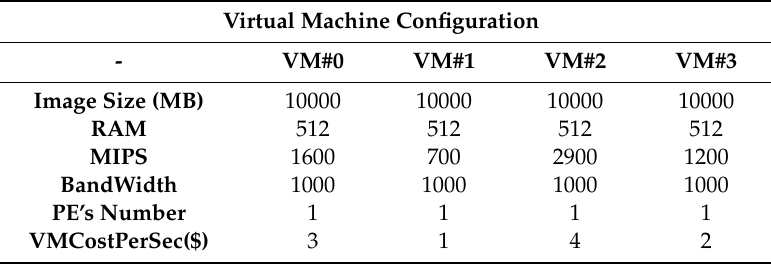
Table 2. Virtual Machine